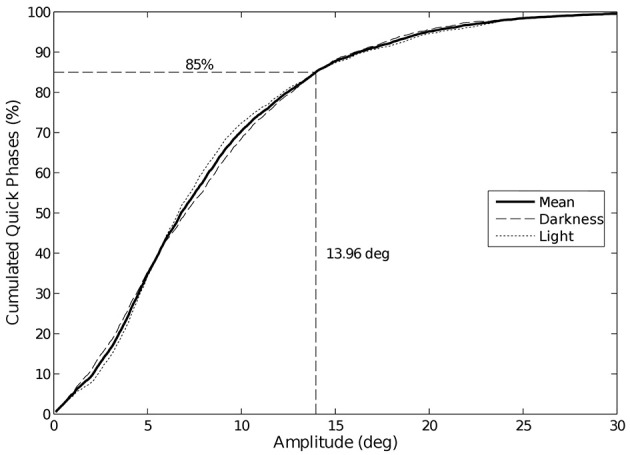
Cumulative distribution of eye quick phases amplitude. 85% of the quick phases have an amplitude lower than 14°. We did not observe any change in amplitude between visual conditions.